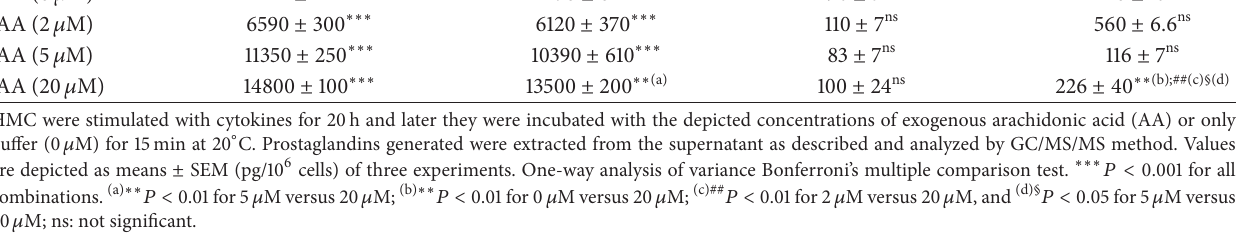
Table 1: Prostanoid formation of cytokine-stimulated HMC from different concentrations of exogenously added arachidonic acid. 6 -Keto-PGF 𝛼 1